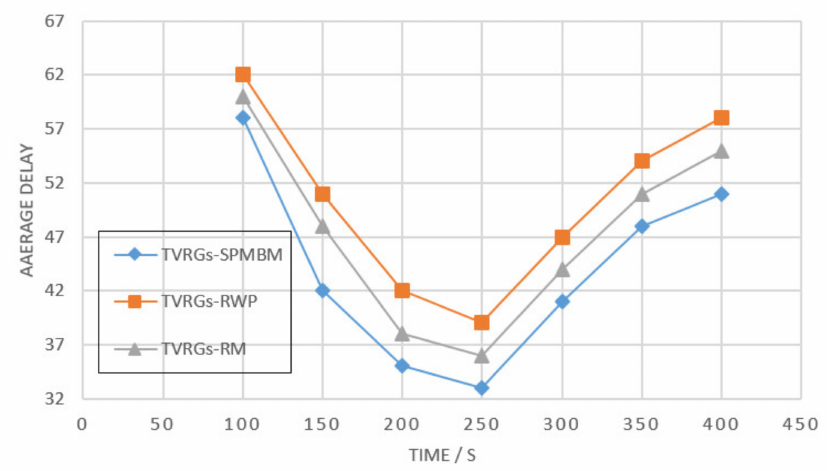
Figure 14. Average delay of different